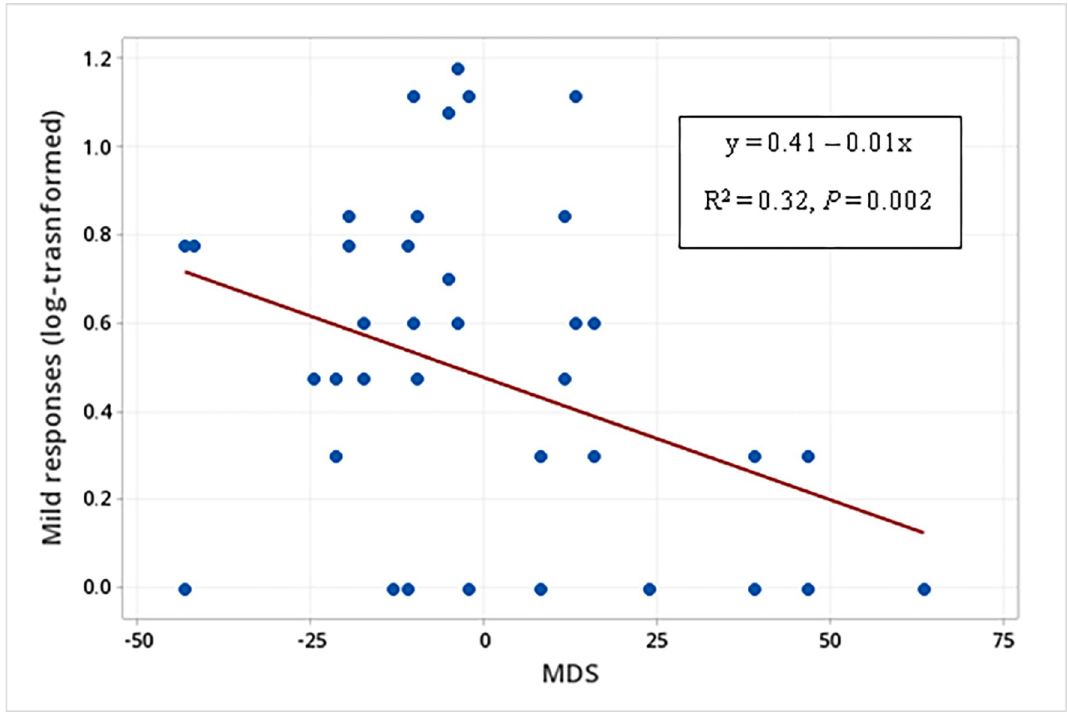
Fig 9. Relationship between the sender’s social rank (MDS) and the occurrence of non-aggressive responses (log-transformed). Occurrence of non-aggressive responses to multimodal signals when white-lipped peccaries (N = 21) were displaying submissive behaviors.